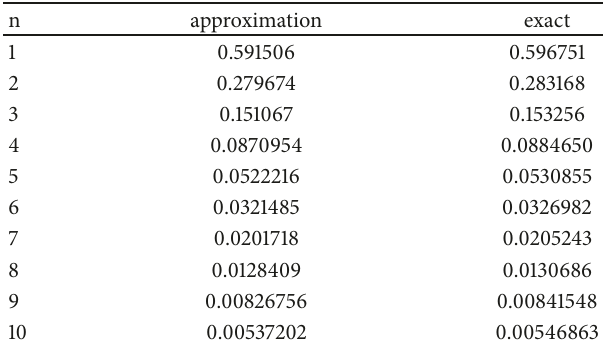
Table 1: Short table for approximation